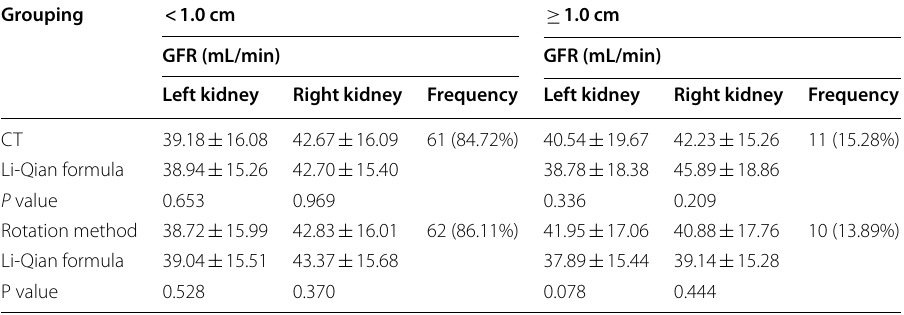
Table 3 Renal depth difference and GFR values were determined by CT and the rotation method ( ¯ x ± s ) Grouping < 1.0